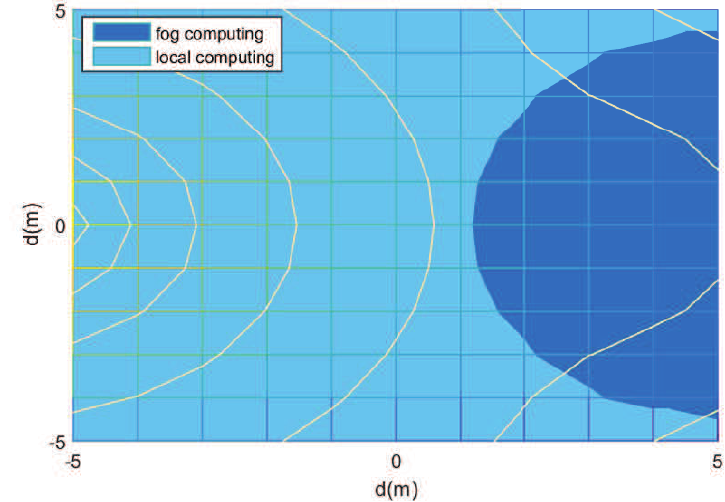
Figure 7. Performance comparison of two computing modes versus the position of the sensor on the 2-D coordinate